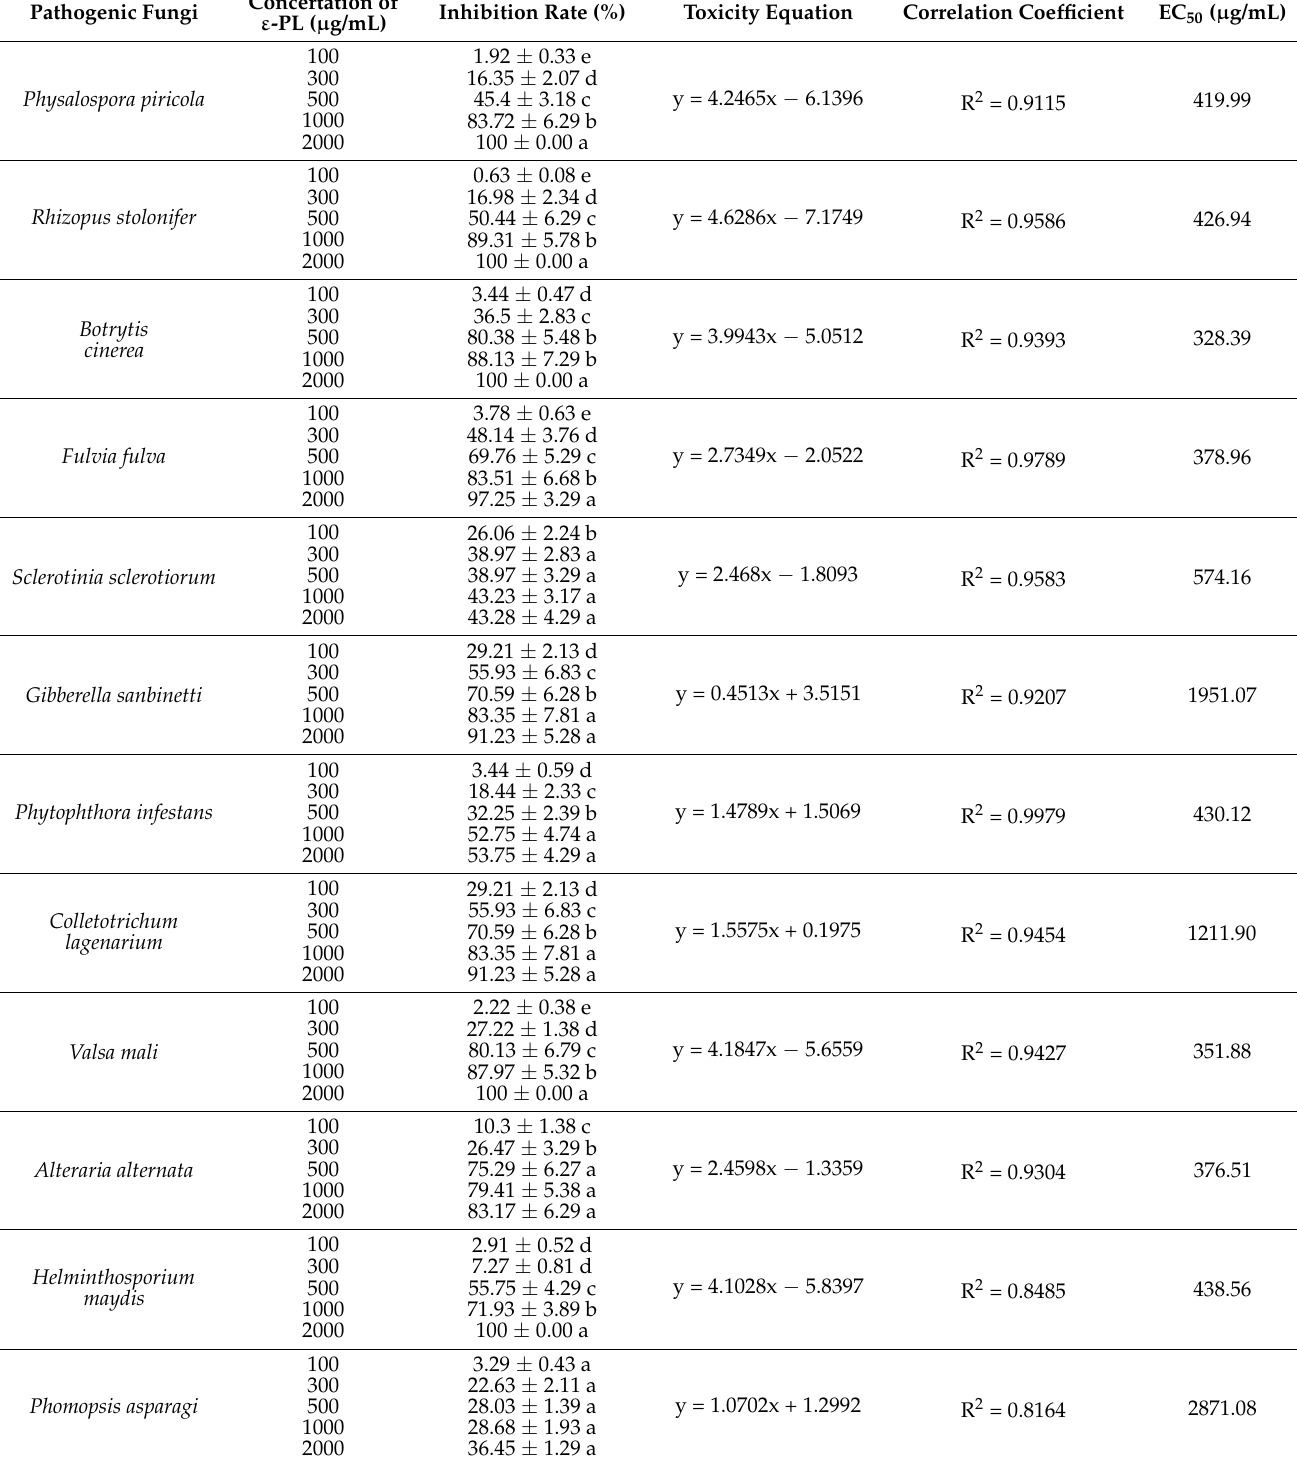
Table 1. Antifungal spectrum of ε -PL treatment toward different plant pathogenic